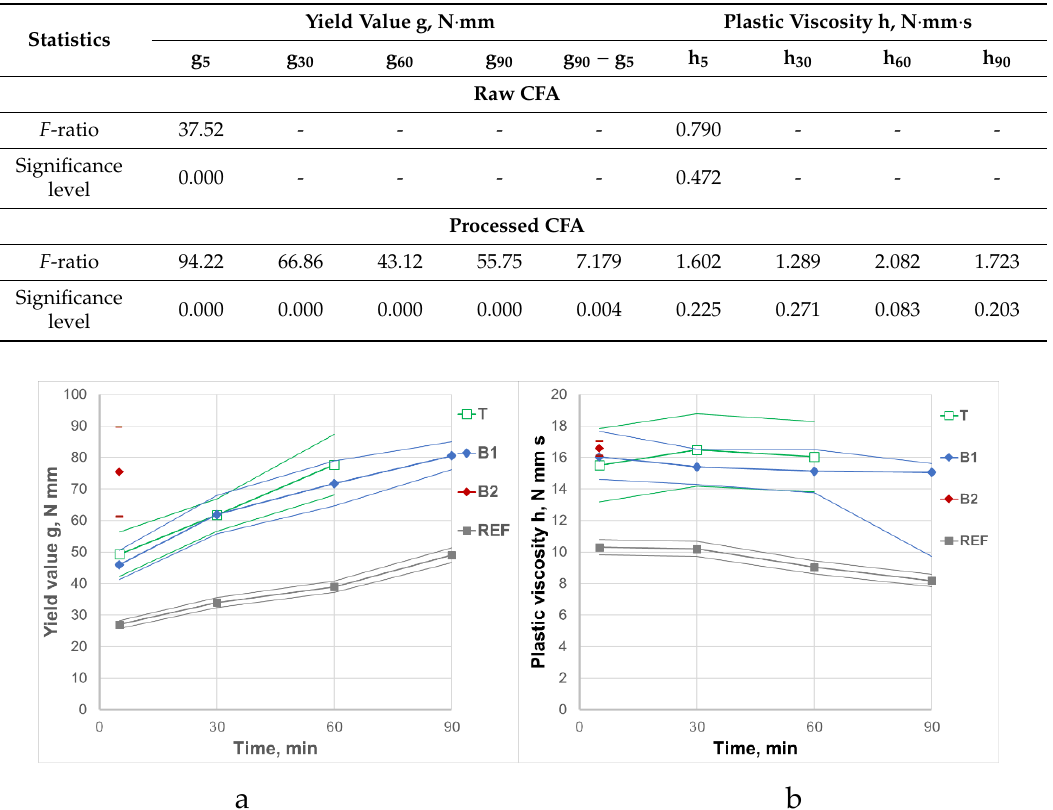
Figure 1. Influence of raw CFA on rheological properties of mortars and its variability. ( a ) Yield value g; ( b ) Plastic viscosity h.